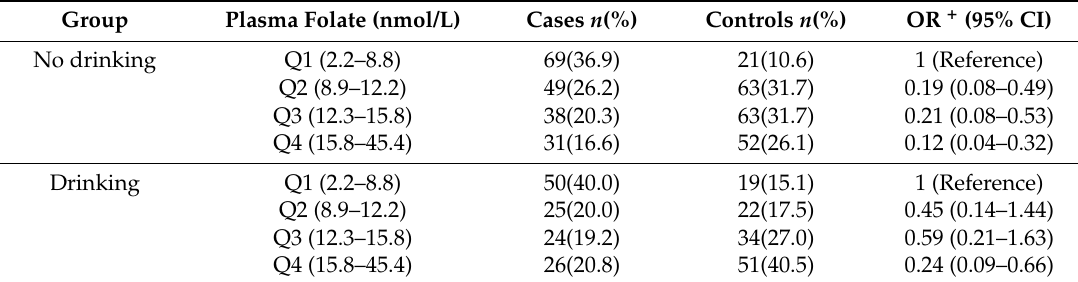
Table 4. Stratified analyses of Odds ratios and 95% confidence intervals of HCC with plasma folate